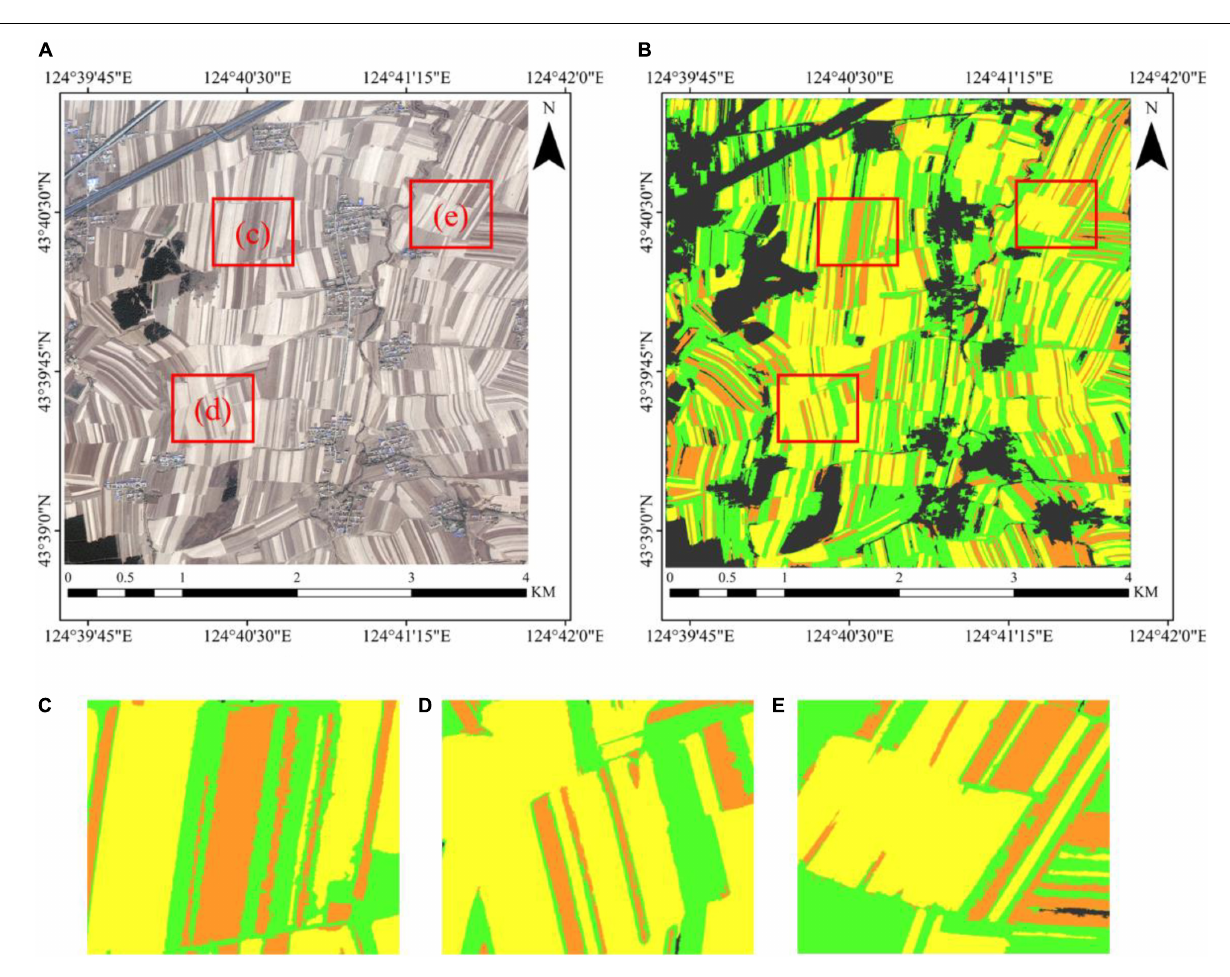
follows: the number of the decision tree is 1,091, the maximum depth of the decision tree is 381, and max features is ‘auto.’ The SVM parameters on DT1 and OID are set as follows: cost or slack parameter is 510.0, gamma value is “scale,” and the kernel type is radial basis function. The 1D-CNN and the 1D-CNN_CA have